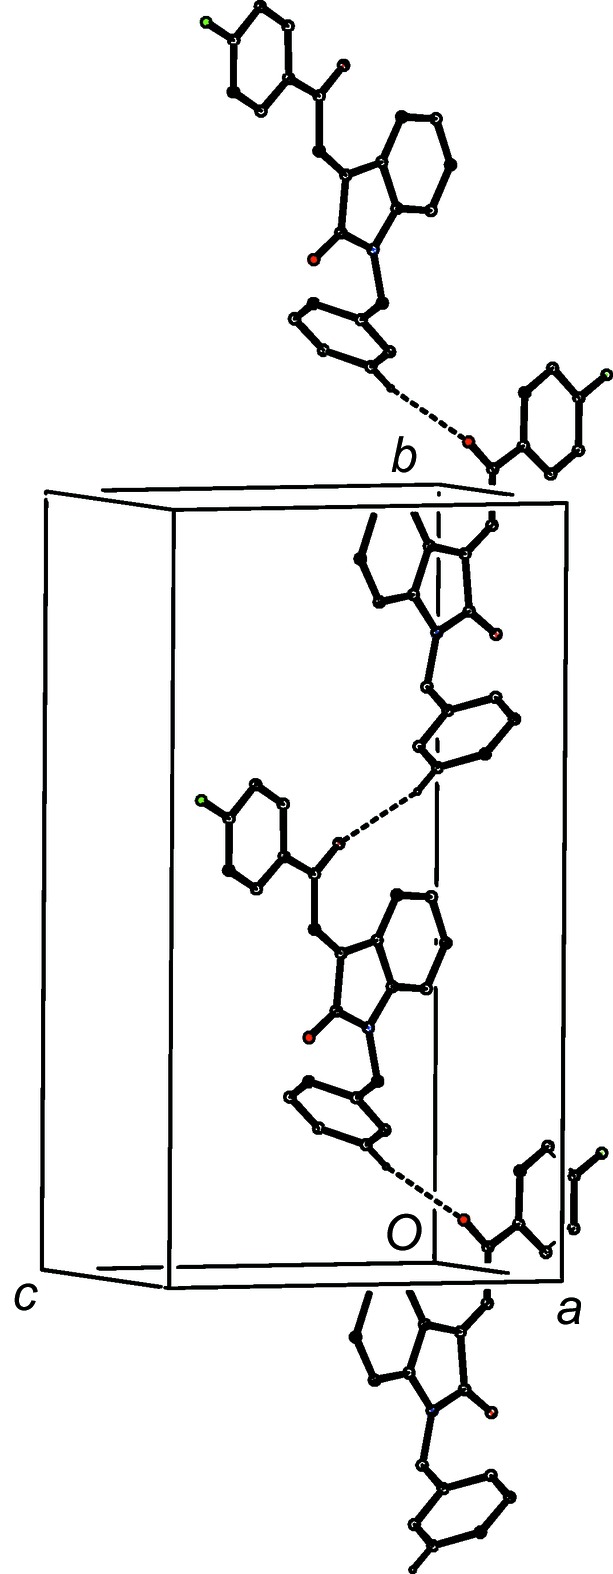
Part of the crystal structure of com­pound (IIa), showing the formation of a hydrogen-bonded chain running parallel to [010]. Hydrogen bonds are drawn as dashed lines and, for the sake of clarity, H atoms not involved in the motif shown have been omitted.